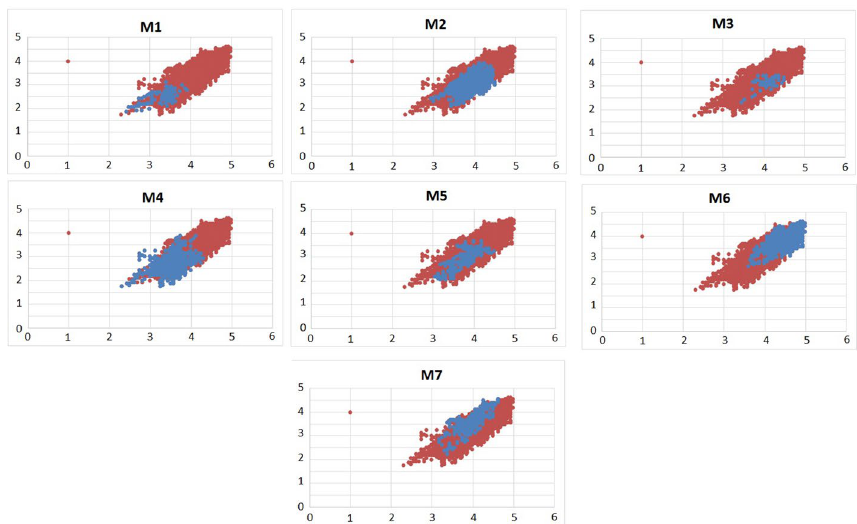
Fig. 9 The correlation between “correctness” and “absolute quality” from the user point of view for some messenger applications based on the IR-QUMA Data. Every point represents average values of one data